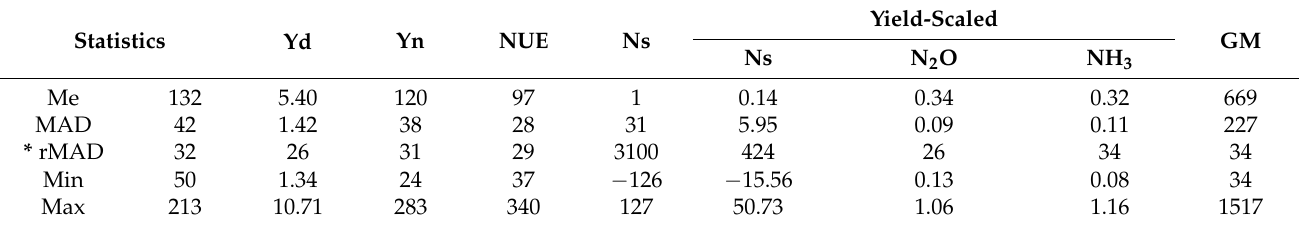
Table 1. Statistics for experimental data ( n = 320); Yd (Mg · ha − 1 ); Yn, Ns (kg · ha − 1 ); NUE (%); yield-scaled Ns, N 2 O, NH 3 (kg N · Mg − 1 ), GM (EUR · ha − 1